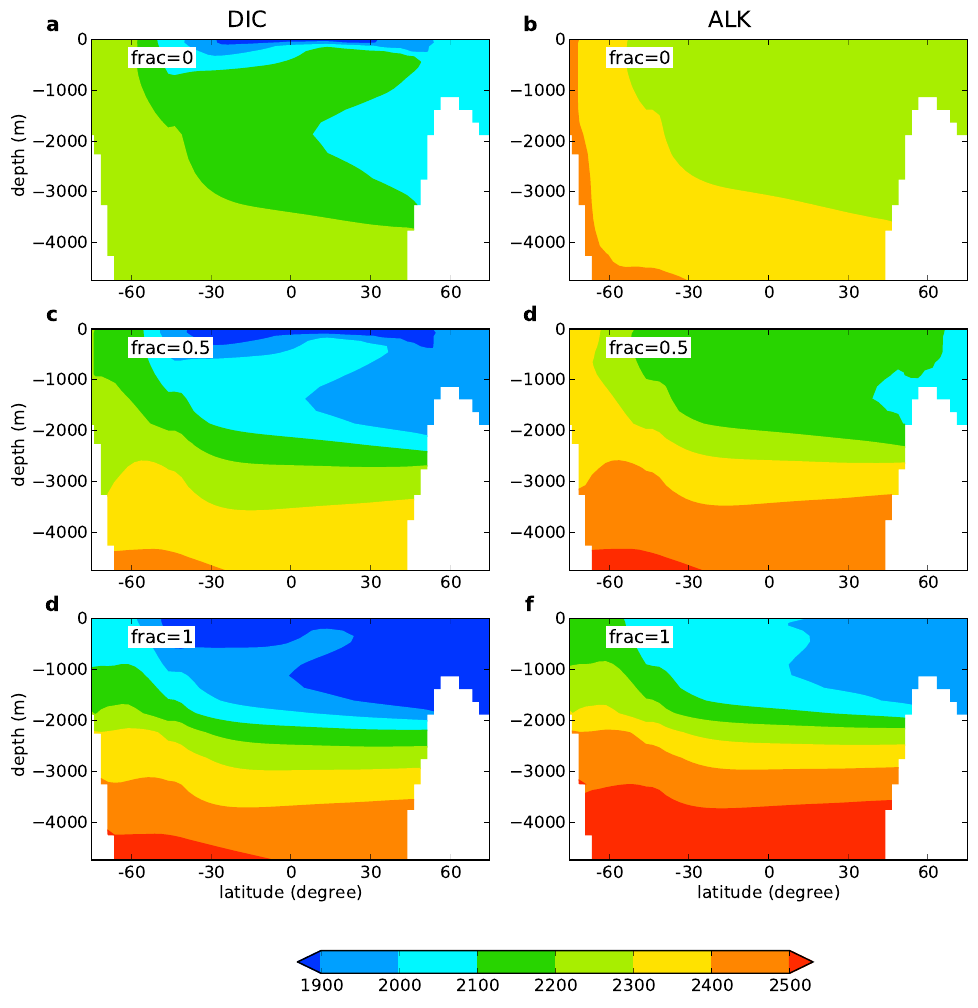
Fig. 6. (a) , (c) , (e) Dissolved inorganic carbon (DIC) (µmol/kg) and (b) , (d) , (f) alkalinity (ALK) (µmol/kg) distribution in the Atlantic for (a), (b) the standard simulation (LGM-std) with frac =0 (no impact of brines), (c), (d) frac =0.5 (medium impact of brines), (e), (f) frac =1 (maximum impact of